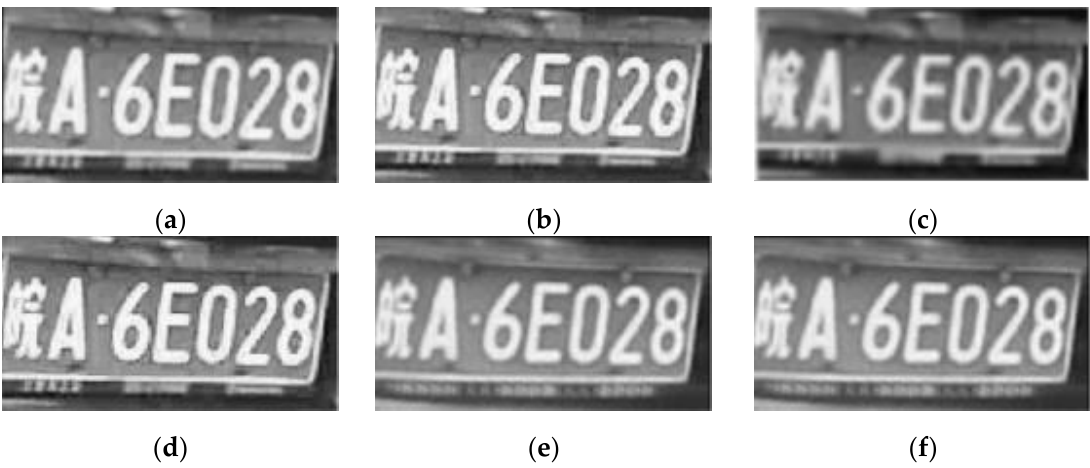
( e ) ( f ) Figure 8. ( a ) Ground Truth ( b ) Bicubic; ( c ) SRCNN; ( d ) ESPCN; ( e ) SRGAN; ( f ) Our algorithm.